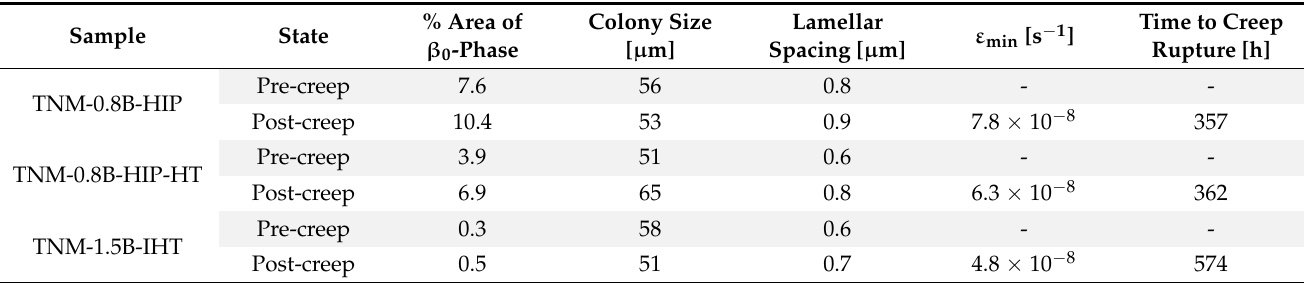
Table 3. Results of the remaining % area of β 0 -phase, lamellar colony size, and α 2 / γ -lamellar spacing of each sample and state.